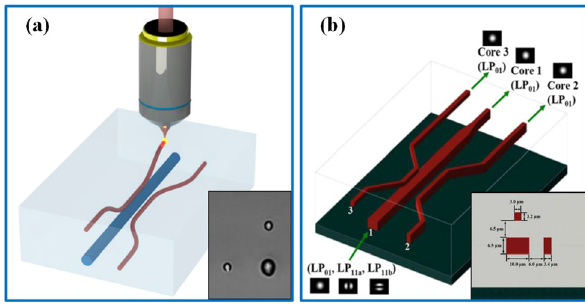
Figure 23: (a) Schematic of a laser-write 3D coupler for LP 11 a and LP 11 b multiplexing; insert: end-face microscope image of the three- core coupler [250]. (b) Schematic of a multilayerasymmetric coupler for LP 11 a and LP 11 b multiplexing; insert: cross section of the three- core coupler